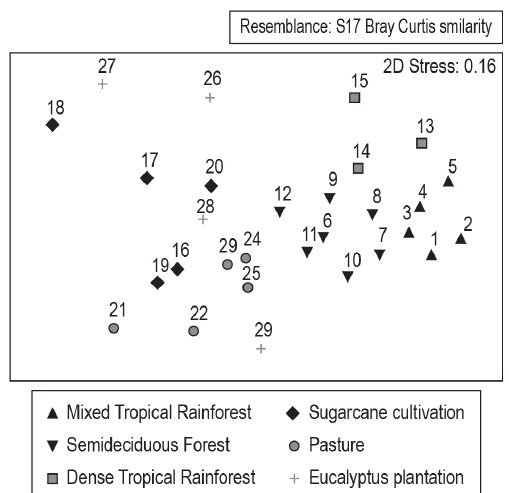
Figure 3. Ordination MDS based on the Bray-Curtis similarity index between of 29 streams in São Paulo